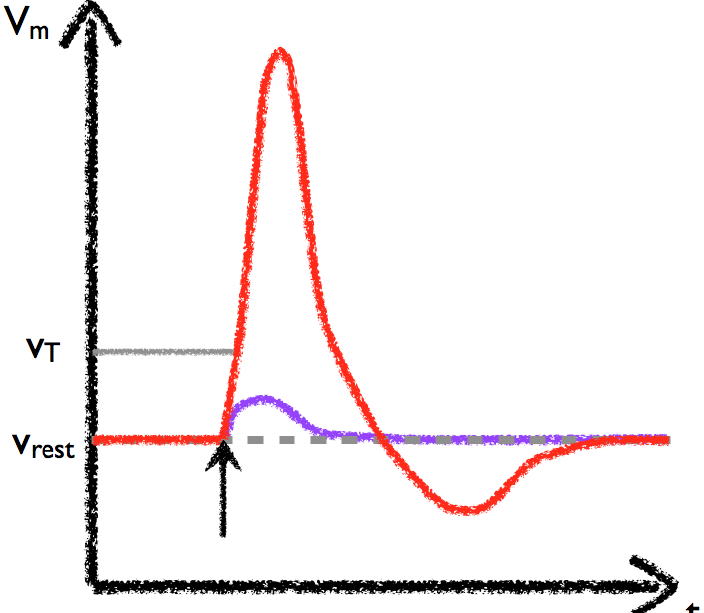
Figure 6. Schematic of an action potential, showing the variation of the membrane voltage, V , at a single location as a function of time. A stimulus of various magnitudes applied at m the time indicated by the arrow triggers a response that is dependent on the magnitude of the stimulus. A small stimulus (purple) results in a small membrane depolarisation that rapidly returns to the resting potential (v , dashed). A large stimulus (red) is sufficient to rest trigger Cl − channels that result in a large membrane depolarisation (the action potential). The initial depolarising stimulus must be greater than some threshold value, v , (indicated T by the grey line) to trigger the Cl − channels and cause the development of the action potential. The action potential is an all or nothing response, any supra-threshold stimuli will result in the same action potential